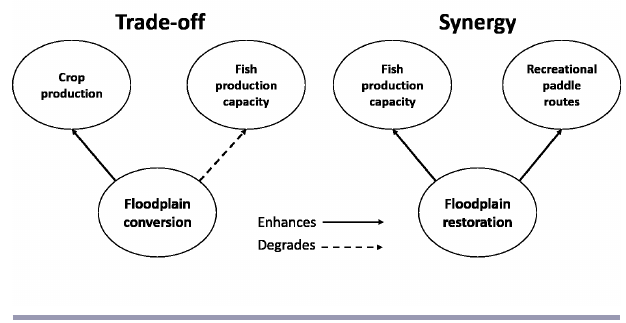
Fig. 1 . Hypothesized interactions among floodplain ecosystem services. Different drivers can lead to interactions such as trade- offs and synergies among ecosystem services. Adapted from Bennett et al.